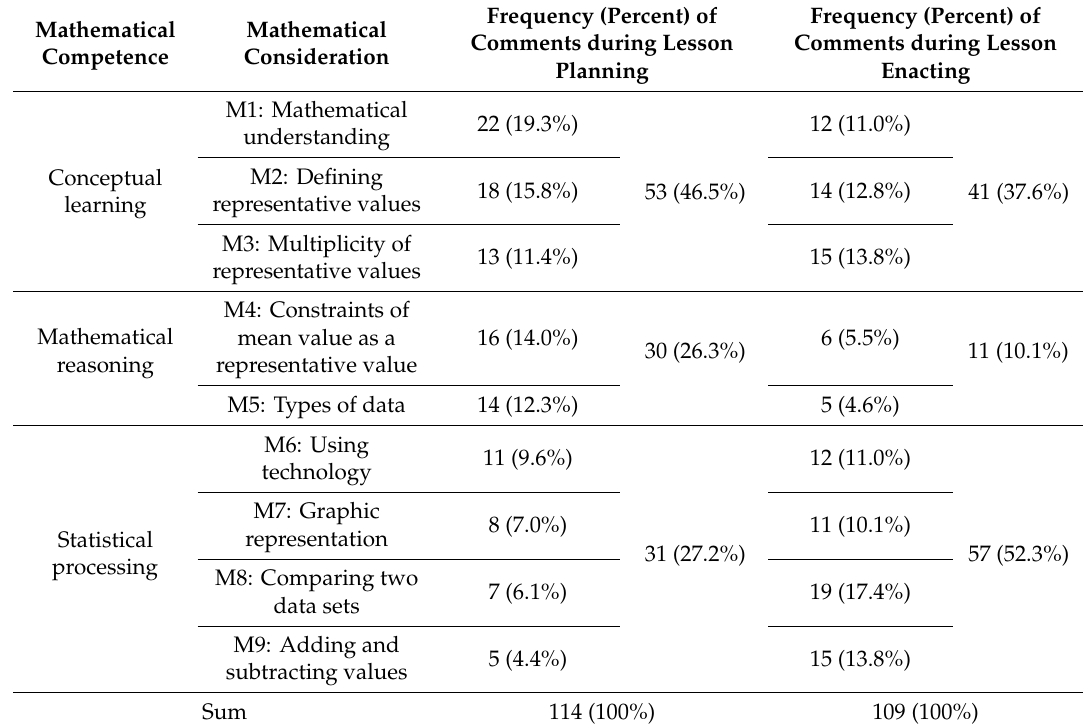
Table 2. Kim’s mathematical